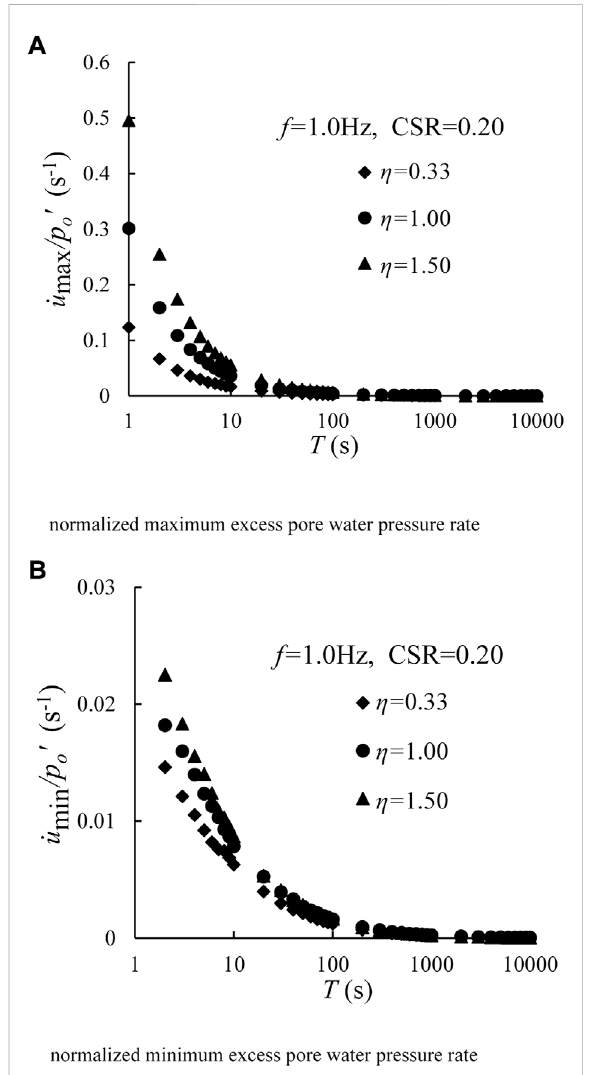
FIGURE 3 Developments of the normalized excess pore water pressure rateversusloadingtimeunderdifferent η forCSR=0.20and f =1.0 Hz. (A) Normalized maximum excess pore water pressure rate and (B) normalized minimum excess pore water pressure rate.